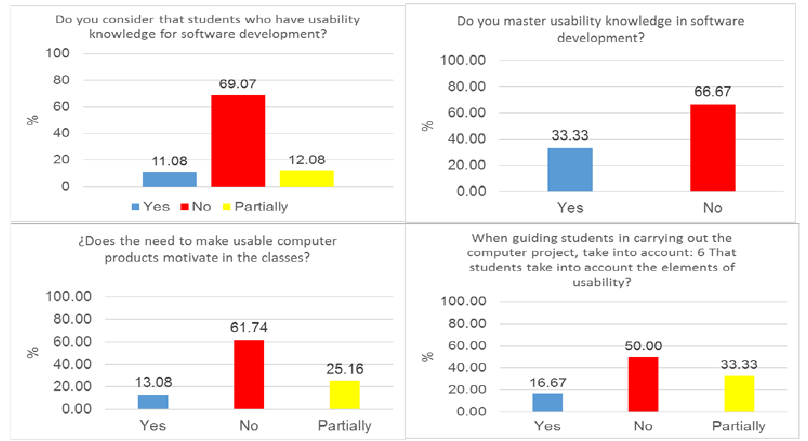
Fig. 1. Results of the survey carried out to 26 professors